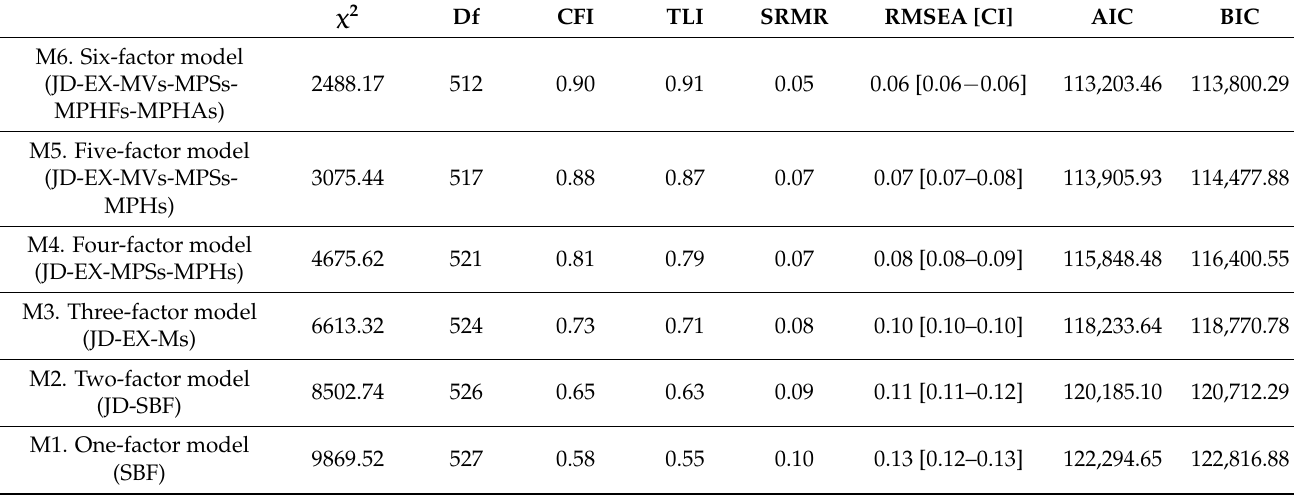
Table 1. Confirmatory factor analyses (CFA): test of alternative models (goodness-of-fit indices). χ